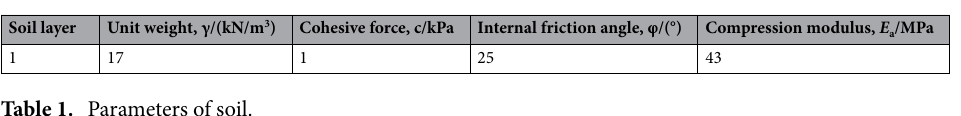
Table 1. Parameters of